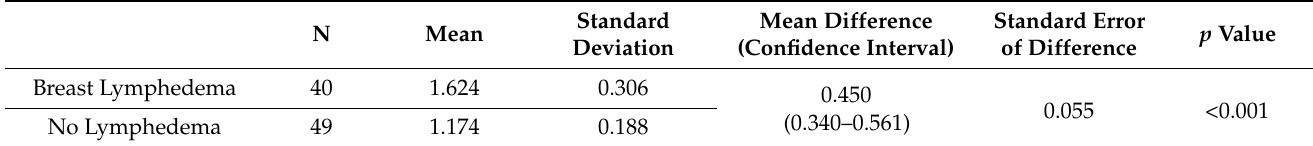
Table 7. Comparison of the Tissue Dielectric Constant Ratios (Affected Breast: Unaffected Breast).